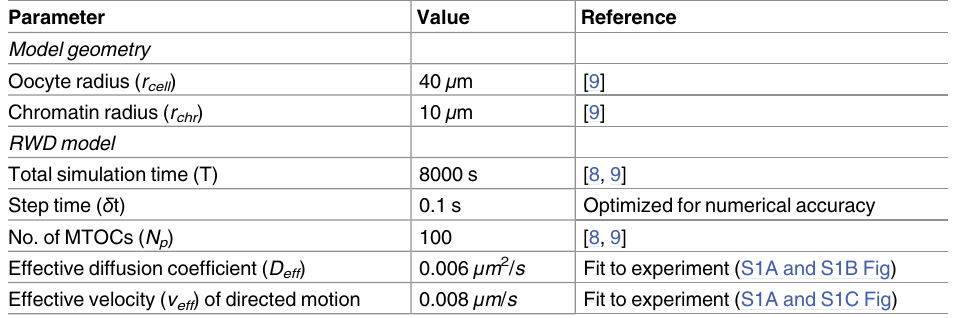
Table 1. RWD model parameters. Parameters are used from literature and fits to experimental